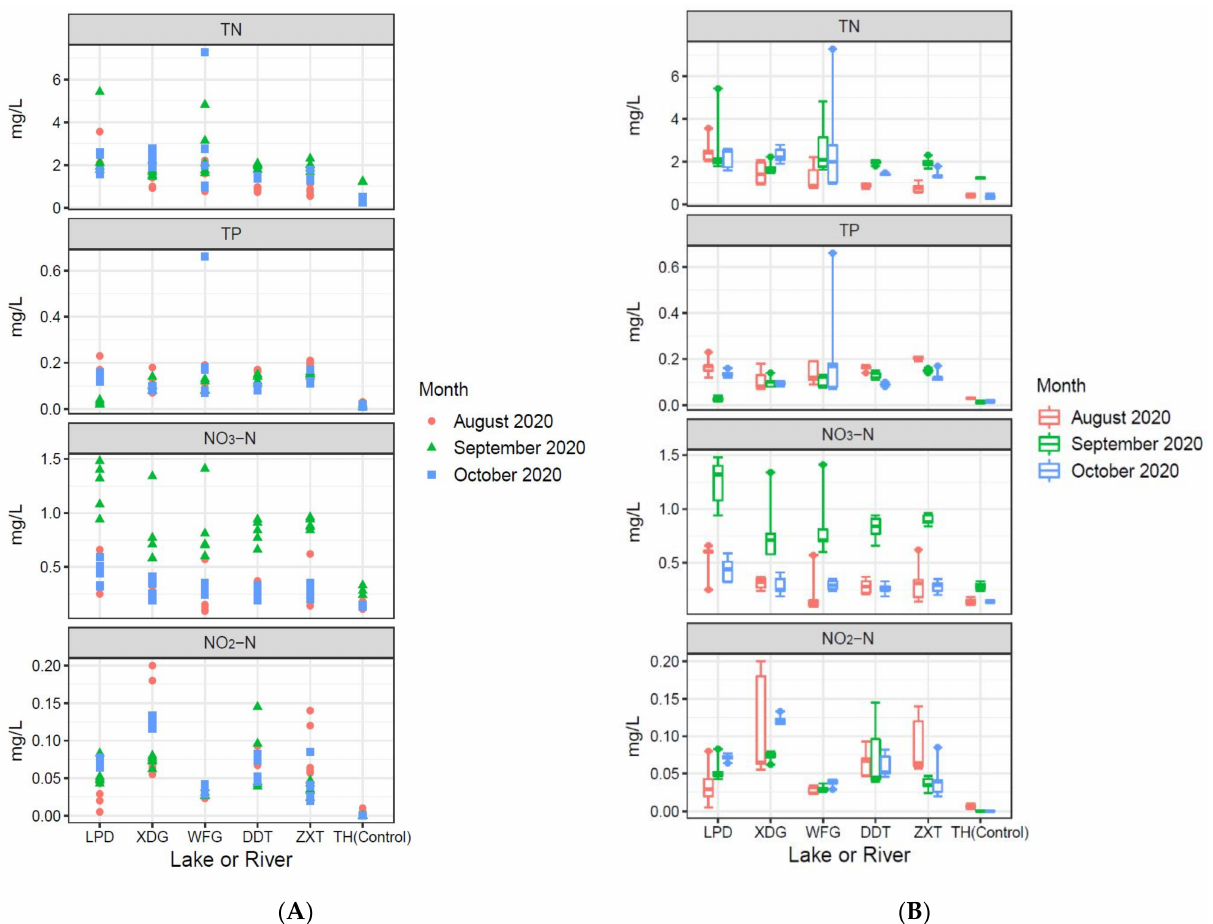
Figure 3. The variation in total nitrogen (TN), total phosphorus (TP), nitrate-N (NO 3 -N), and nitrite-N (NO 2 -N) values observed in different sampling locations and months. The individual value for each parameter ( A ) and boxplots ( B ) with minimum and maximum values (whiskers), median value (line within each box), and quartile interval (box) are